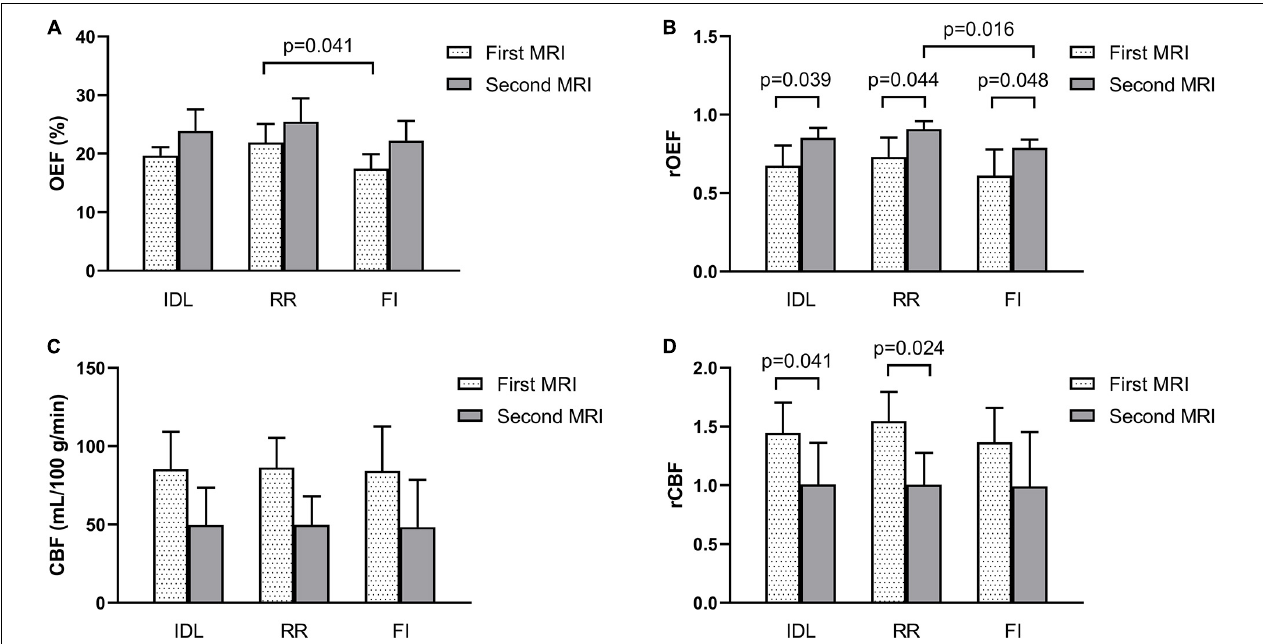
FIGURE 5 | Parameters of the IDL, RR, and FI between the longitudinal MRI scans in five patients who showed reversal of IDL. (A) OEF. (B) rOEF. (C) CBF. (D) rCBF. OEF, oxygen extraction fraction; rOEF, relative OEF; CBF, cerebral blood flow; rCBF, relative CBF; IDL, initial diffusion lesion; RR, reversal region; FI, final infarct.